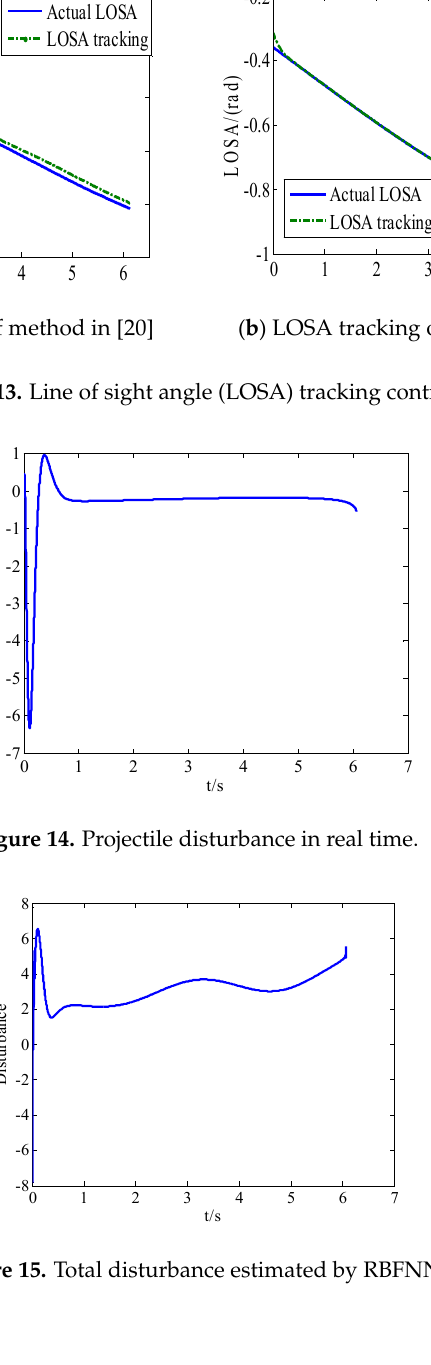
6 K = . Figure 16. Contrast of trajectory with different guidance proportional coefficients.